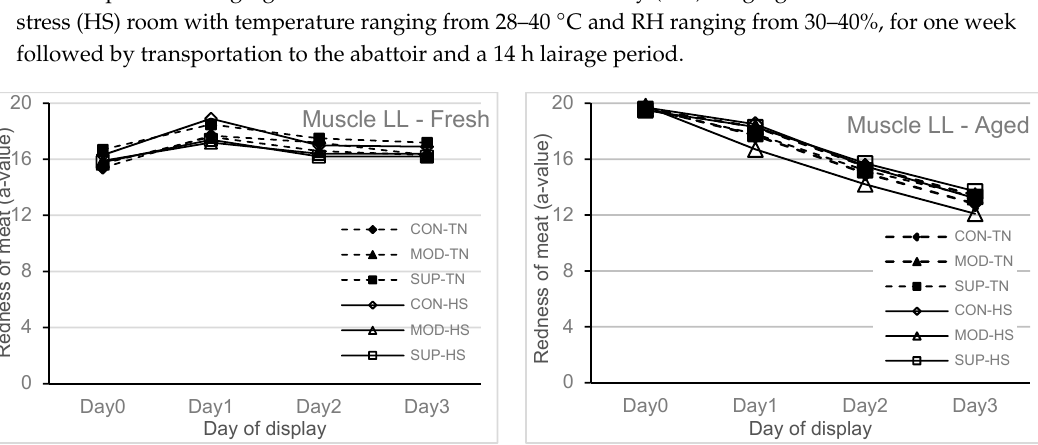
Figure 2. Redness (a-value) of fresh and aged (packaged and stored for 42 days at 2 °C) meat (muscle LL) assessed at 1 h (Day 0), 24 h (Day 1), 48 h (Day 2) and 72 h (Day 3) of simulated retail display condition (3–4 °C) from lambs fed four weeks of experimental diets and followed by one week of thermal treatment. See Figure 1 for an explanation of the labels.